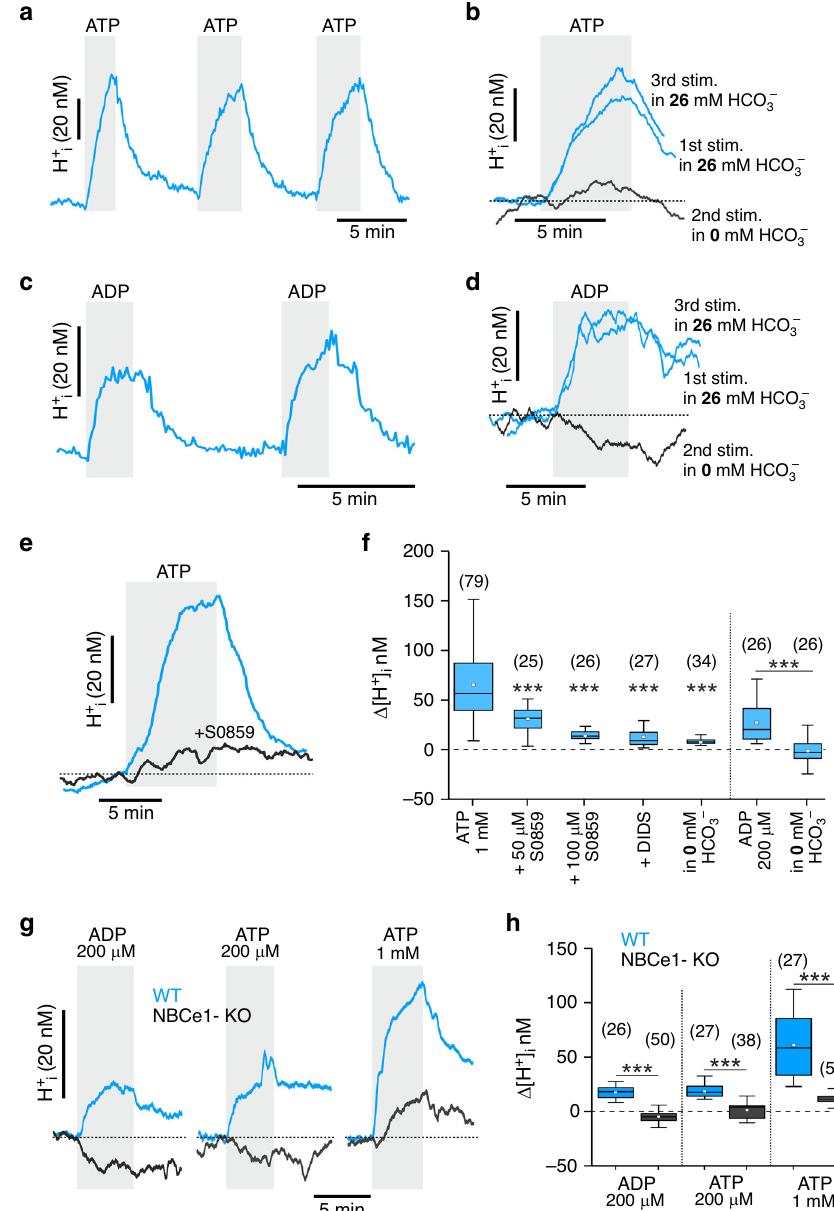
Fig. 3 Bicarbonate transport in astrocytes is modulated by purinergic signalling. a Representative example of intracellular acidi fi cation induced by ATP in cortical astrocytes in culture. The trace depicts averaged [H + ] i responses of 17 astrocytes to repeated application of ATP (1 mM) in culture. b ATP-induced intracellular acidi fi cation in astrocytes is reversibly blocked by removal of extracellular HCO 3 − . Averaged traces of ATP-induced [H + ] i responses in 9 astrocytes in the presence and absence of HCO 3 − in the media are shown. c Representative example of intracellular acidi fi cation induced by ADP in cortical astrocytes in culture. The trace depicts averaged [H + ] i responses of 9 astrocytes to repeated application of ADP (200 µ M) in culture. d ADP-induced intracellular acidi fi cation in astrocytes is reversibly blocked by removal of extracellular HCO 3 − . Averaged traces of ADP-induced [H + ] i responses in 14 astrocytes in the presence and absence of HCO 3 − in the media are shown. e ATP-induced intracellular acidi fi cation in astrocytes is blocked by sodium bicarbonate co-transporter (NBC) inhibitor S0859 (100 µ M). Averaged traces of ATP-induced [H + ] i responses in 12 astrocytes are shown. f Summary data illustrating the effects of pharmacological inhibition of NBC (S0859, DIDS) or removal of extracellular HCO 3 − on peak increases in [H + ] i induced by ATP or ADP in astrocytes. g Representative examples of averaged [H + ] i responses to ADP or ATP in 12 cultured astrocytes of wild-type (WT) and 12 astrocytes of electrogenic sodium-bicarbonate cotransporter 1 (NBCe1) knockout (NBCe1-KO) mice. h Summary data illustrating peak changes in [H + ] i induced by ATP and ADP in astrocytes of WT and NBCe1-KO mice. In the box-and-whisker plots the central dot indicates the mean, the central line indicates the median, the box limits indicate the upper and lower quartiles and the whiskers extend to 1.5 IQR from the quartiles. Numbers in parentheses indicate the numbers of individual astrocytes recorded in 3 – 5 separate cultures prepared from the same number of animals. *** denotes difference from the response recorded in control conditions ( f ) or in WT astrocytes ( h ) with p < 0.001 (one-way ANOVA with Tukey ’ s post-hoc test). Source data are provided as a Source Data fi